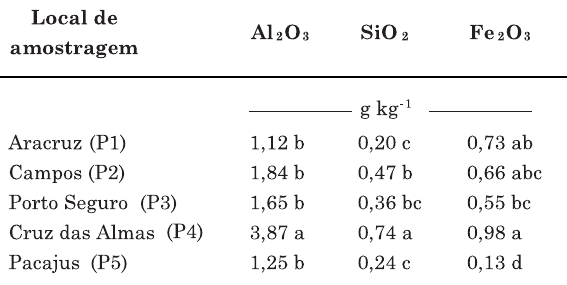
Quadro 3. Teores médios (n=3) dos